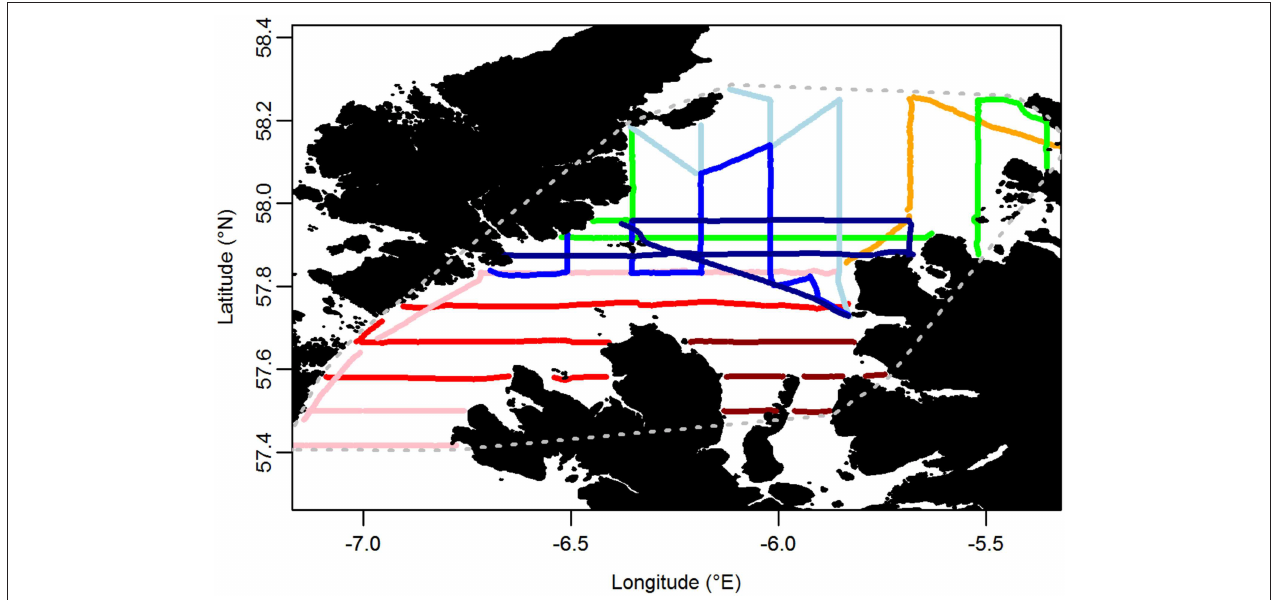
FIGURE 3 | Transects carried out on at-sea surveys. Each color represents a different day of the survey. Gray dotted line encompasses the area over which indices of similarity between at-sea and tracking based distributions were calculated.